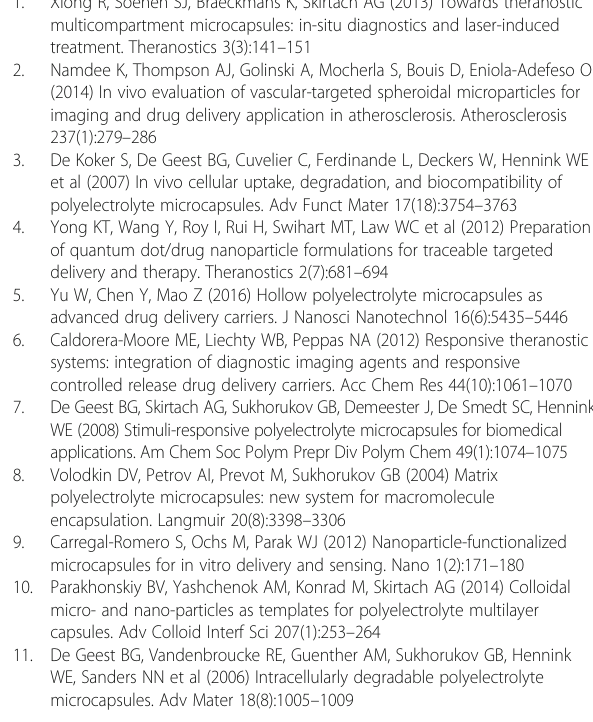
Additional file 1: Figure S1. Schematic diagram of a theranostic agent based on polyelectrolyte microcapsules. Figure S2. Size distributions of calcium carbonate microparticles obtained at stirring rates of 250 ( a ), 500 ( b ), and 750-rpm ( c ). The stirring duration was 30 s in all cases. The size distribution diagrams are based on the measurements of individual microparticles ( n =350). The differences between samples a , b , and c are significant ( p < < 0.05). Figure S3. Size distributions of calcium carbonate microparticles obtained at stirring durations of 15 ( a ), 30 ( b ), and 60 s ( c ). The stirring rate was 250 rpm in all cases. The size distribution diagrams are based on the measurements of individual microparticles ( n =350). The differences between samples a , b , and c are significant ( p <<0.05). Figure S4. Size distribution of the solubilized quantum dots as estimated by the volume occupied by the particles ( a ), the number of the particles ( b ), or the light scattering intensity ( c ). (DOCX 457